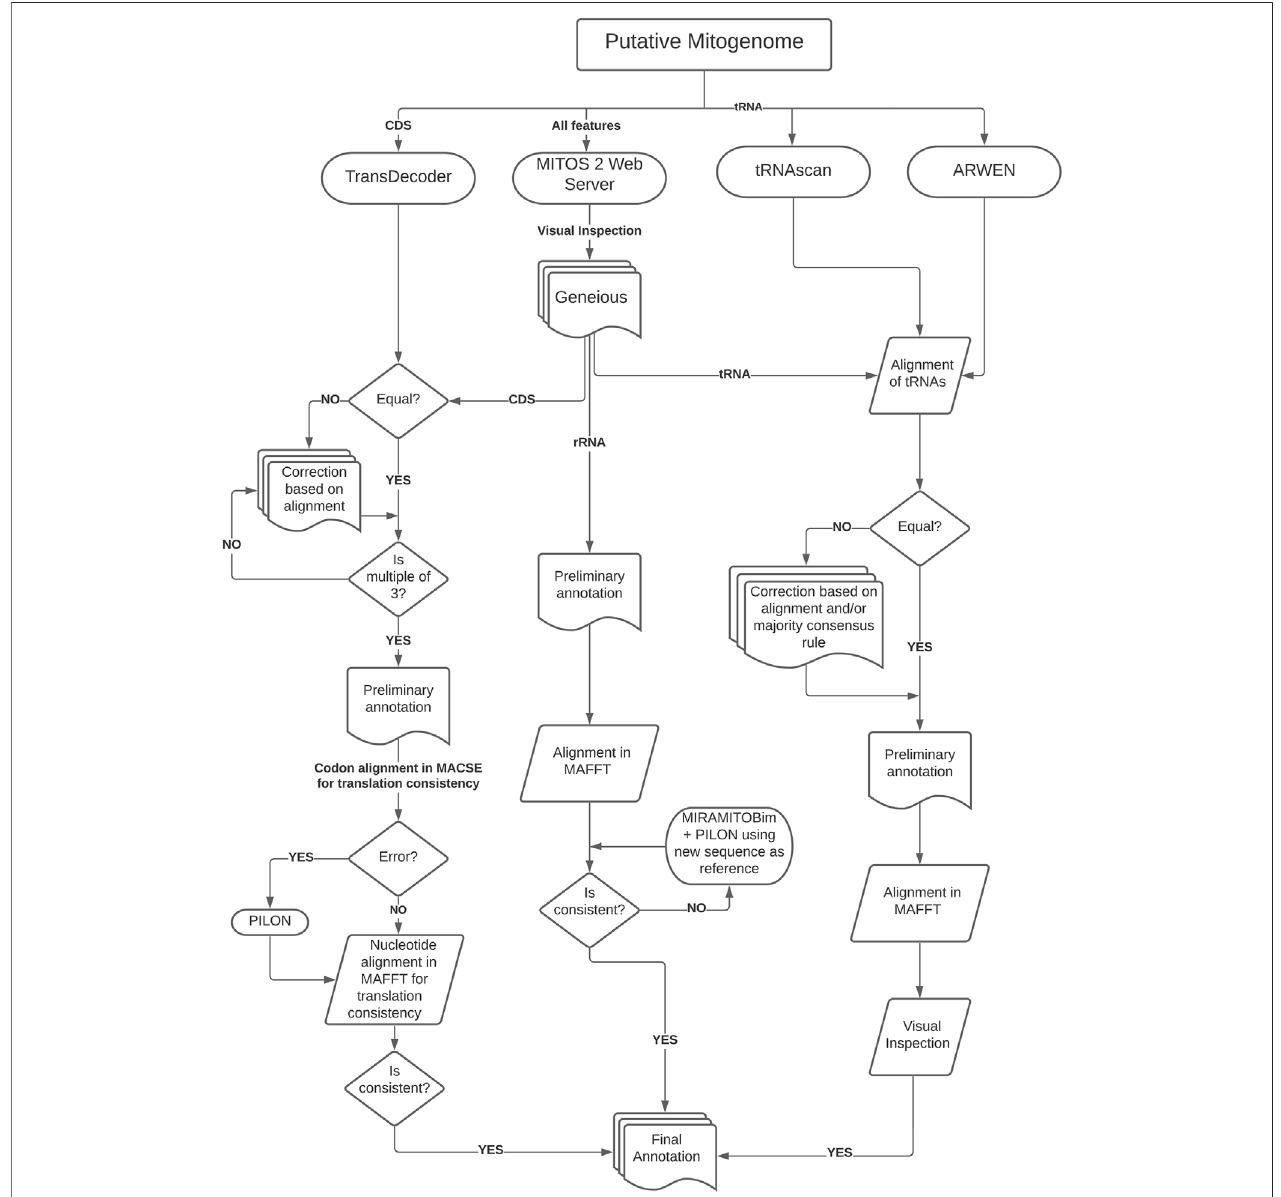
FIGURE 1 | Schematic work fl ow of the annotation protocol used in this study.